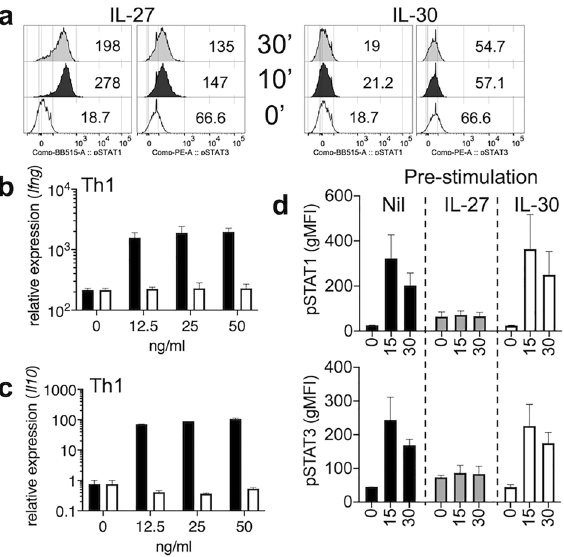
Figure 6. IL-30 stimulation in CD4 T cell activation in vitro. ( a ) FACS sorted CD4 + naïve cells were stimulated with recombinant IL-27, IL-30. Phosphorylated STAT1 and STAT3 expression was determined by flow cytometry at 10- and 30-min following stimulation. ( b , c ) Naive CD4 T cells were stimulated under Th1 polarization conditions in the presence of IL-27 (filled bar) or IL-30 (open bar) (0–50 ng/mL) for 3 days. Ifng and Il10 mRNA expression was determined by qPCR. ( d ) Naïve CD4 T cells were incubated with media (Nil), 50 ng IL-27, or 50 ng IL-30 for one hour. The cells were then washed and restimulated with IL-27. Stat1 and Stat3 phosphorylation was determined by flow cytometry at 15 and 30 min following stimulation. The data shown are representative of two independent